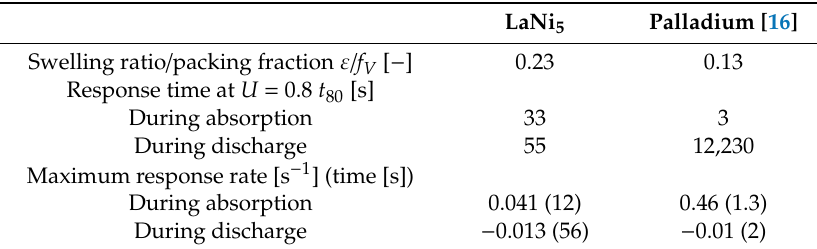
Table 2. Performance of LaNi 5 and palladium as an actuator when P up = 0.5